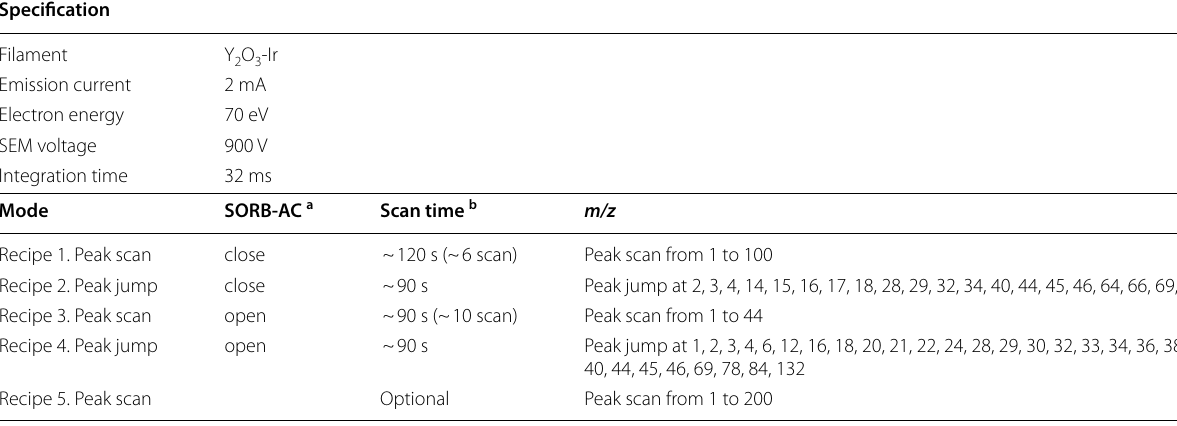
A procedure plan used for the measurements of gases in the Hayabusa2 sample container Measurements are performed sequentially from Recipe 1 to Recipe 4 in each gas fraction Recipe 5 is also applied in the case where the gas amount is high a Gases are measured without SORB-AC and then with SORB-AC by opening the valve b Basic scan time depends on the gas amount and